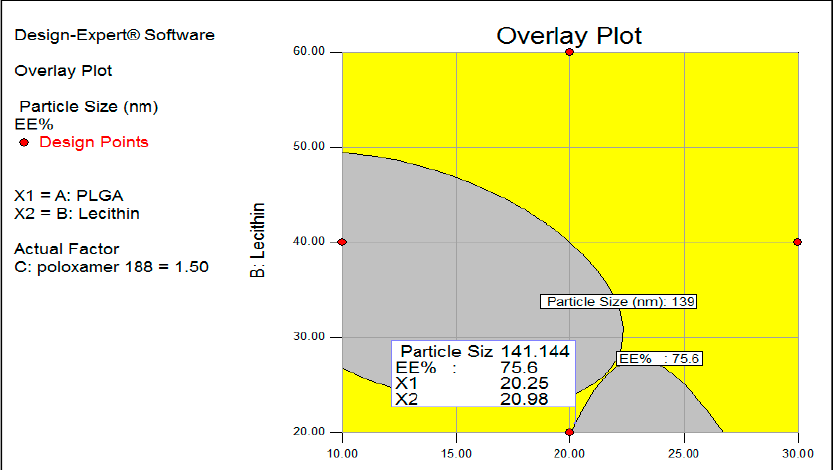
Figure 4. Design space for PLGA-lecithin 5FU nanoparticles. Gray areas show the possible situations to obtain the desired readings for a 141 nm average particle size and 75.6 EE%.